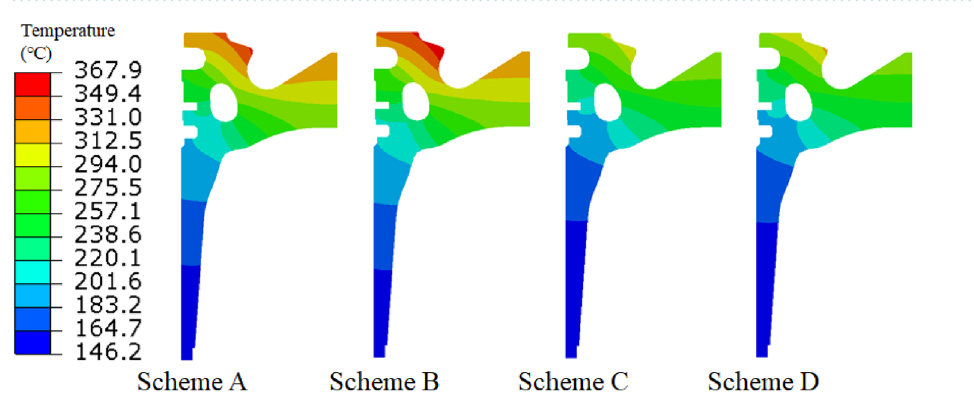
Figure 8. Temperature field distribution of